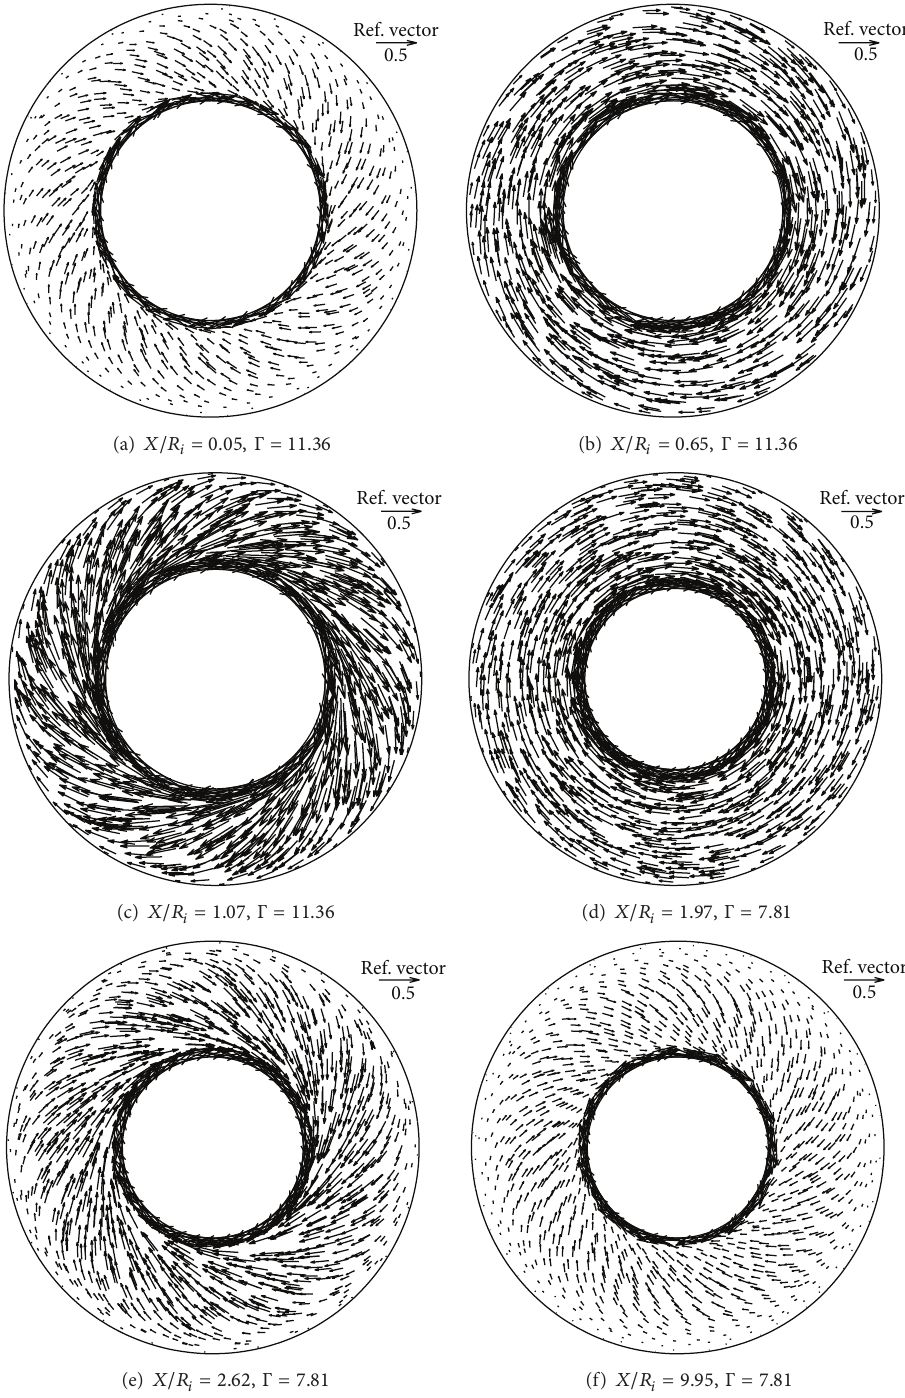
Figure 5: Velocity vectors in the axial plane normalised by Ω𝑅 𝑖